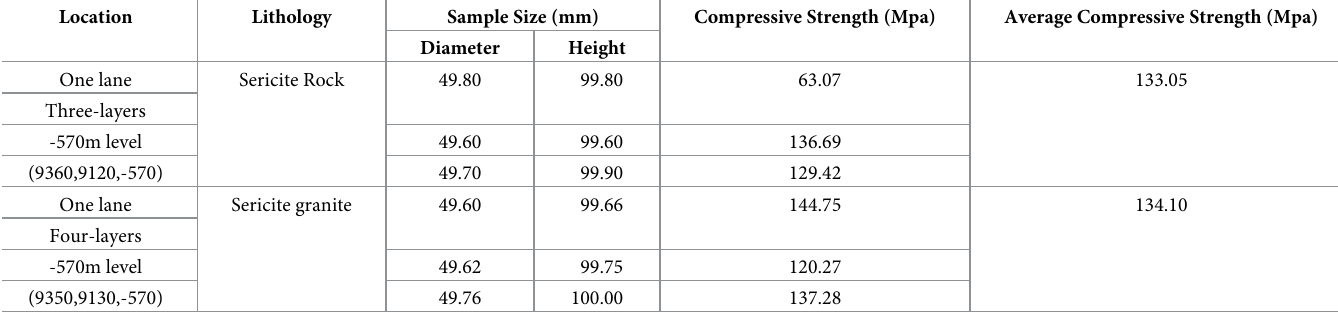
Table 4. Uniaxial compression test results of the -570m level